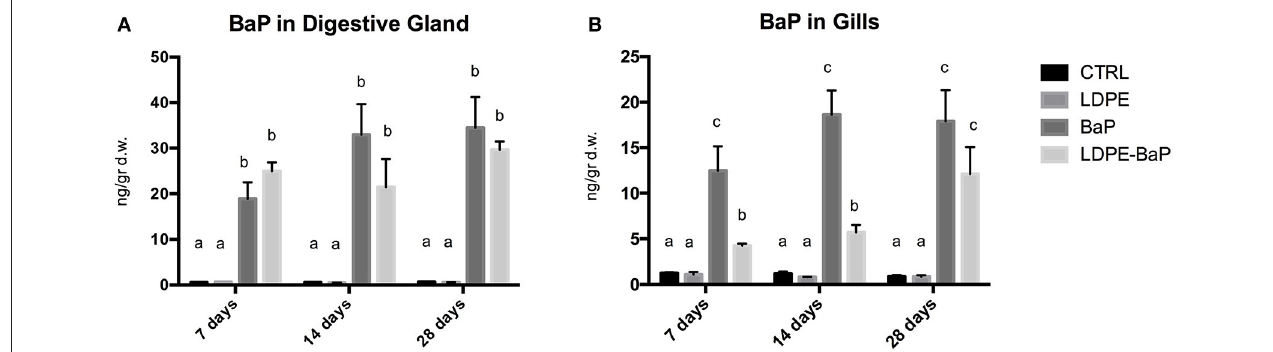
FIGURE 1 | Concentrations of benzo(a)pyrene in digestive glands (A) and gills (B) of mussels exposed for 7, 14, and 28 days to various treatments (CTRL, control; LDPE, virgin low density polyethylene; BaP, benzo(a)pyrene alone; LDPE-BaP, benzo(a)pyrene-contaminated polyethylene). Data are expressed as ng/g dry weight (mean values ± standard error, n = 4); different letters indicate significant differences between groups of means within the same time of exposure ( post-hoc Newman-Keuls comparison).